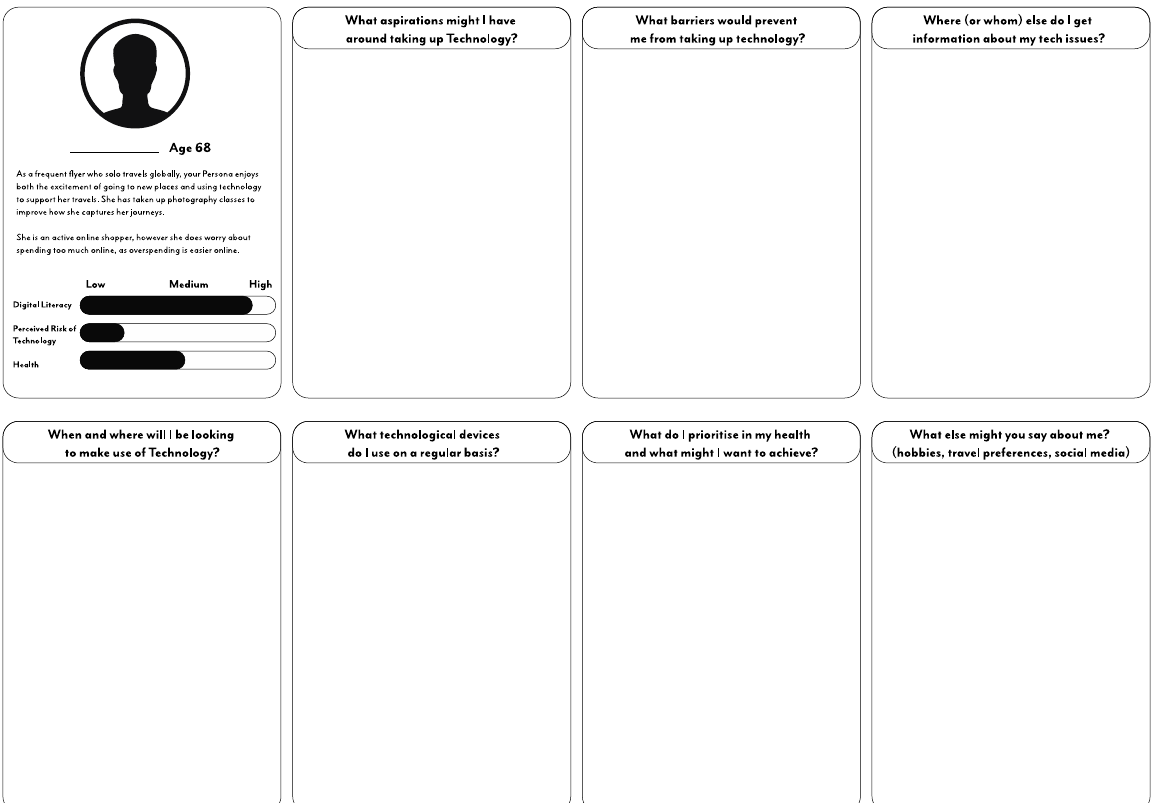
Figure 2. Basic persona profiles.